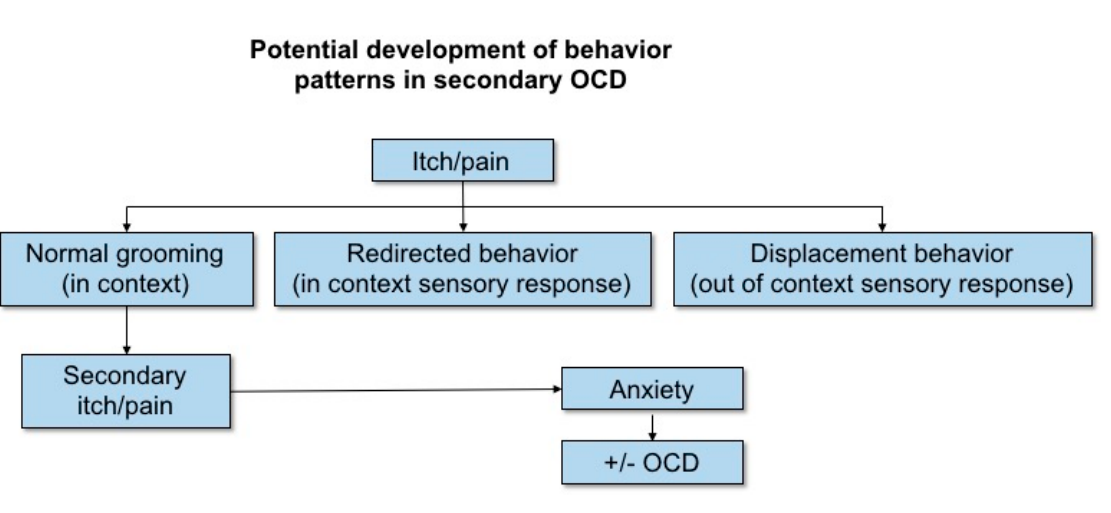
Figure 1. Schematic for how compulsive disorder (OCD) could develop as a secondary condition to dermatological concerns involving pruritus and or / pain. Figure reproduced from Overall, 2013 [39] page number 276, chapter 7, with permission of the rights holder, Elsevier.